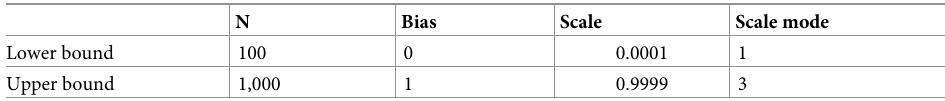
Table 5. Lower and upper space-search bounds for all metaheuristic